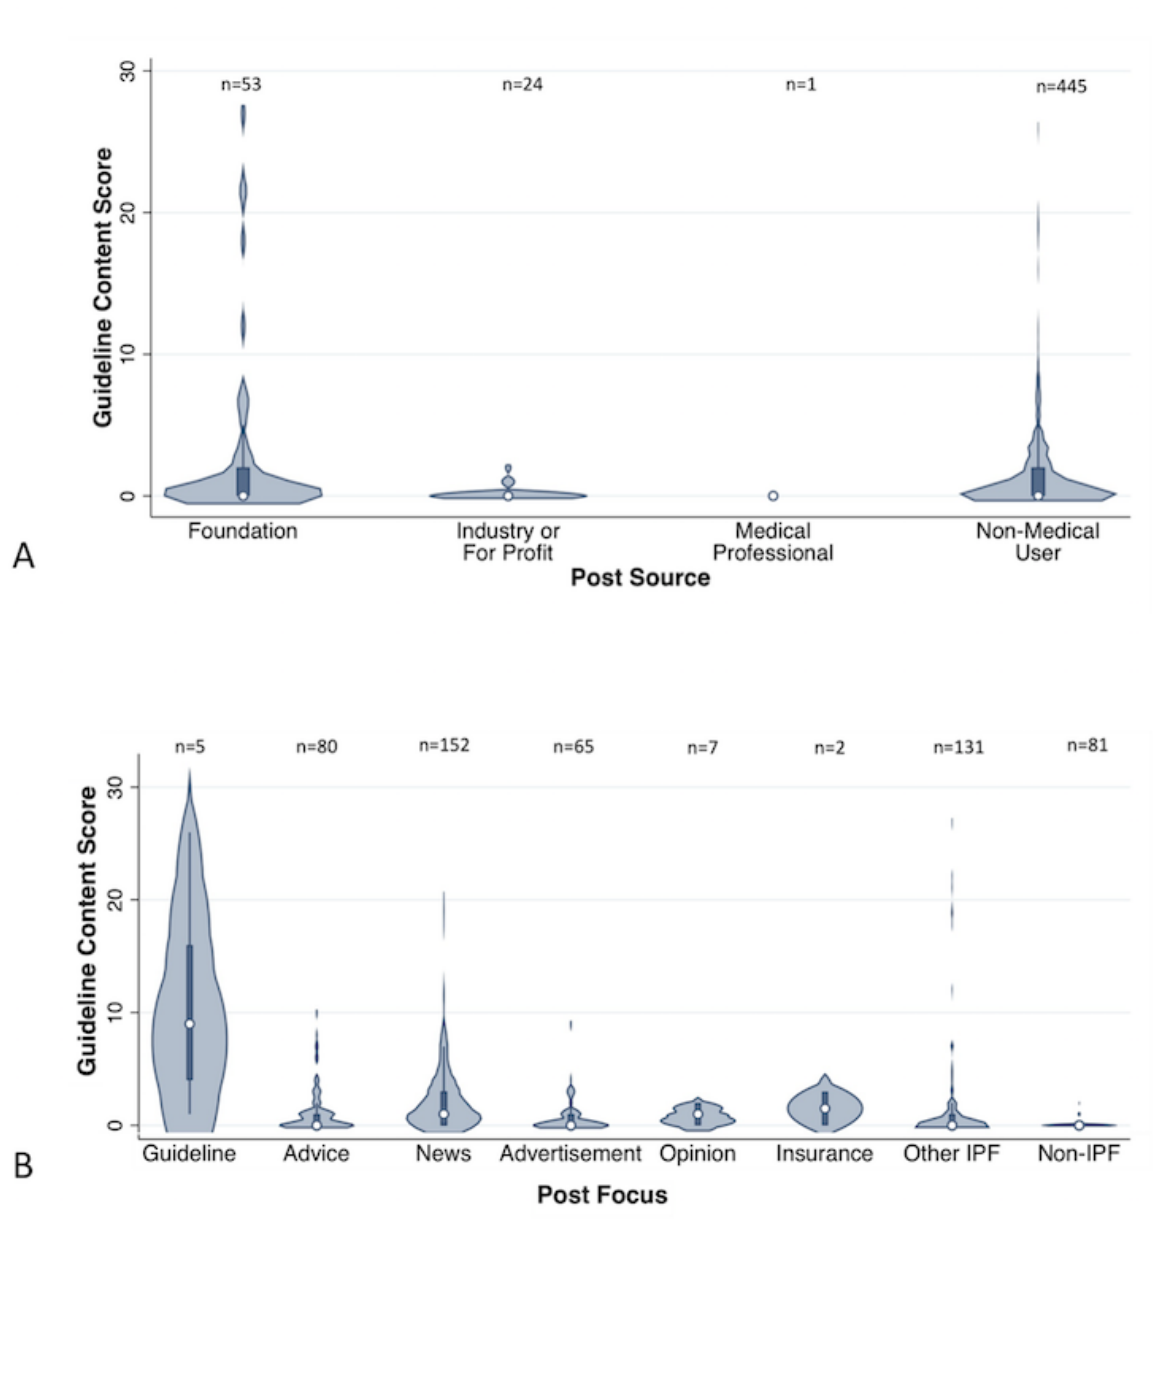
Figure 3. Content score reflecting the number of guideline-recommended content contained in each post or immediate link from groups and pages combined (maximum score=30). The width of the plot at each level corresponds to the number of posts within that group that had that score. Medians with IQRs are presented as a box plot within the violin plot. Posts are delineated by source (A) and focus